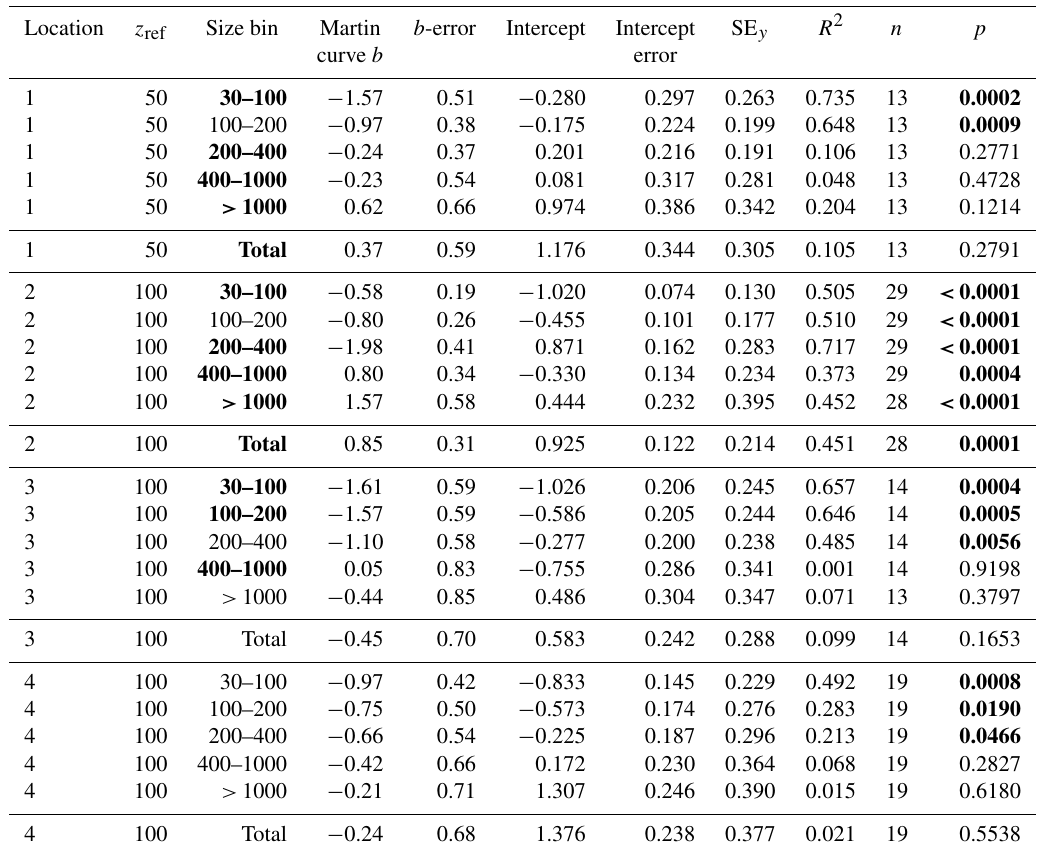
Table 3. Martin curve fits to attenuance flux (all dives).